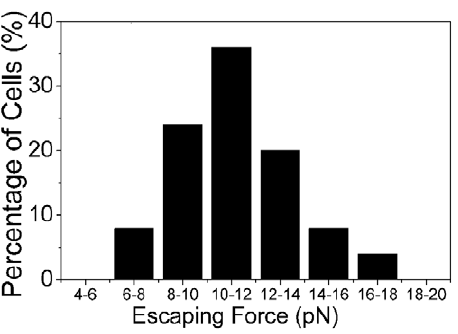
Figure 9. Histogram depicting the lower limit of the force required to separate two adhered neural progenitor cells. This corresponds to the force required by a cell to escape from the flow cell of the optical trap schematically depicted in Fig 1B and 1C. Data presented pertains to measurements made on 56